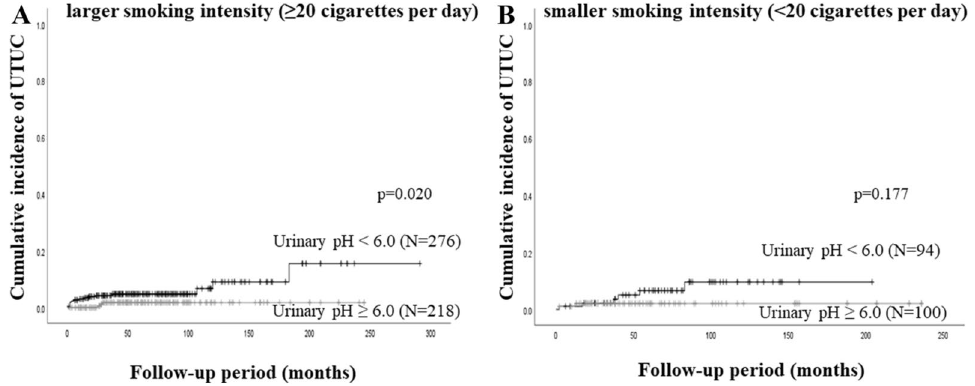
Figure 4. Cumulative incidence of UTUC recurrence stratified by urinary pH levels in patients who had a smoking history and ( A ) larger smoking intensity (≥ 20 cigarettes per day) or ( B ) smaller smoking intensity (< 20 cigarettes per